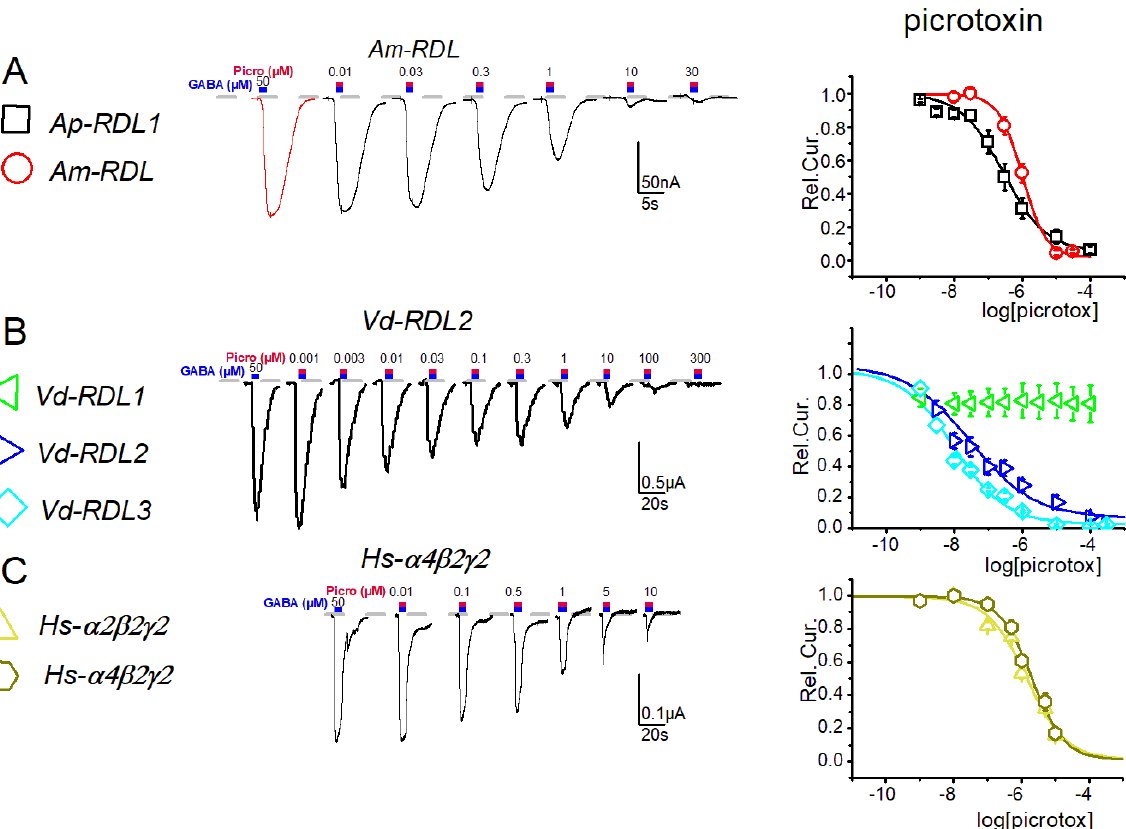
Figure 5. Dose–response curves for picrotoxin obtained for the seven GABA-A receptors RDL from A. pisum and A. mellifera ( A ), RDL1, RDL2 and RDL3 from V. destructor ( B ), and α 2 β 2 γ 2 and α 4 β 2 γ 2 from H. Sapiens ( C ). ( Left ): representative current traces from 1 type of receptor; ( Right ): full dose–response curves. The IC 50 are summarized in Supplementary Table S1.